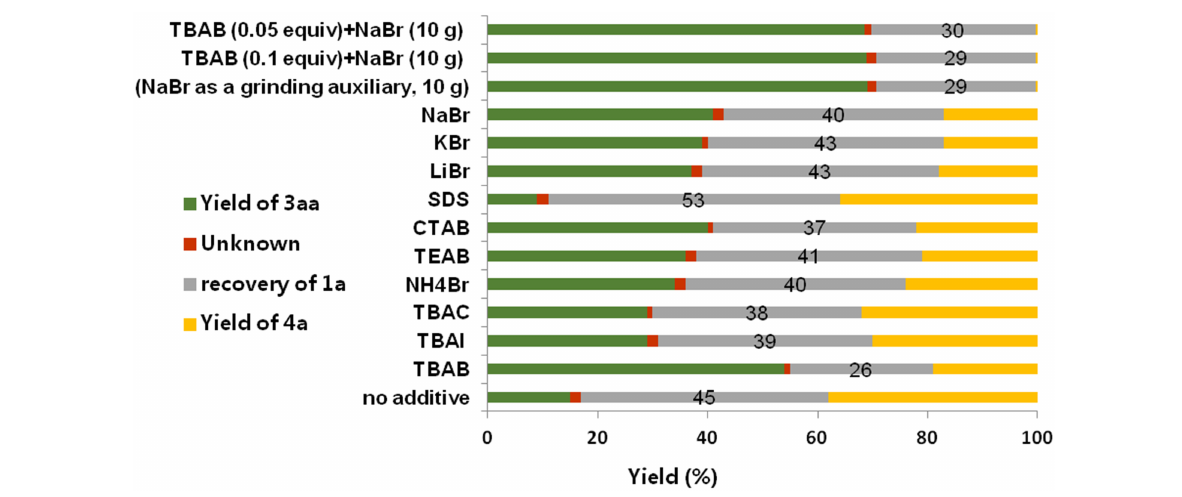
Figure 1: Investigation of additives in the Heck reaction: 1a (1.5 mmol), 2a (2.25 mmol), Pd(OAc) 2 (5 mol %), PPh 3 (10 mol %), TEA (1.8 mmol), addi- tive (3.0 mmol), and silica gel (5.0 g) were placed in an 80 mL stainless steel vessel along with 173 stainless-steel balls ( d MB = 6 mm, Ф MB = 0.245), milling at 800 rpm for 90 min.